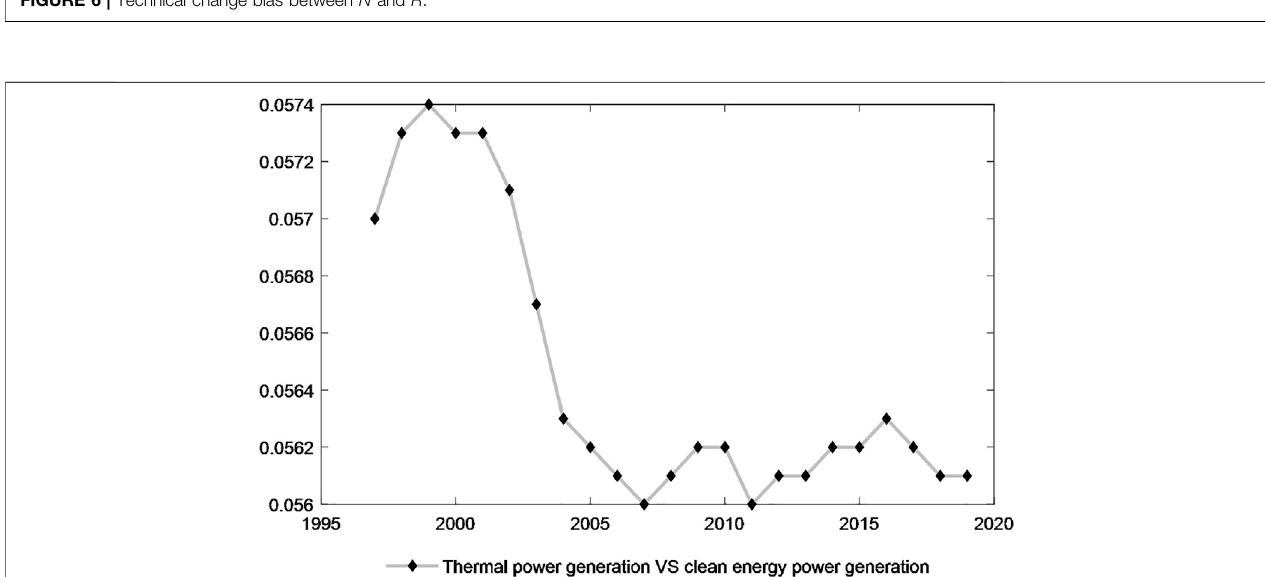
FIGURE 6 | Technical change bias between N and R .